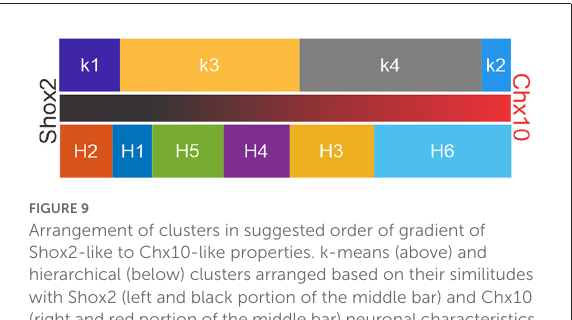
FIGURE9 Arrangement of clusters in suggested order of gradient of Shox2-like to Chx10-like properties. k-means (above) and hierarchical (below) clusters arranged based on their similitudes with Shox2 (left and black portion of the middle bar) and Chx10 (right and red portion of the middle bar) neuronal